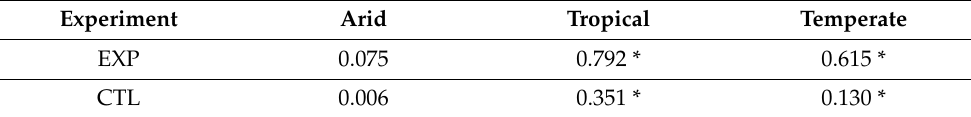
Table 2. Correlation coefficients of the volumetric soil moisture in GDAPS-KIM and SMOPS in arid, tropical, and temperate regions during the boreal summer season. The asterisks indicate statistical significance at the 99% confidence level, and no asterisks indicate no statistical significance (under the 90% confidence